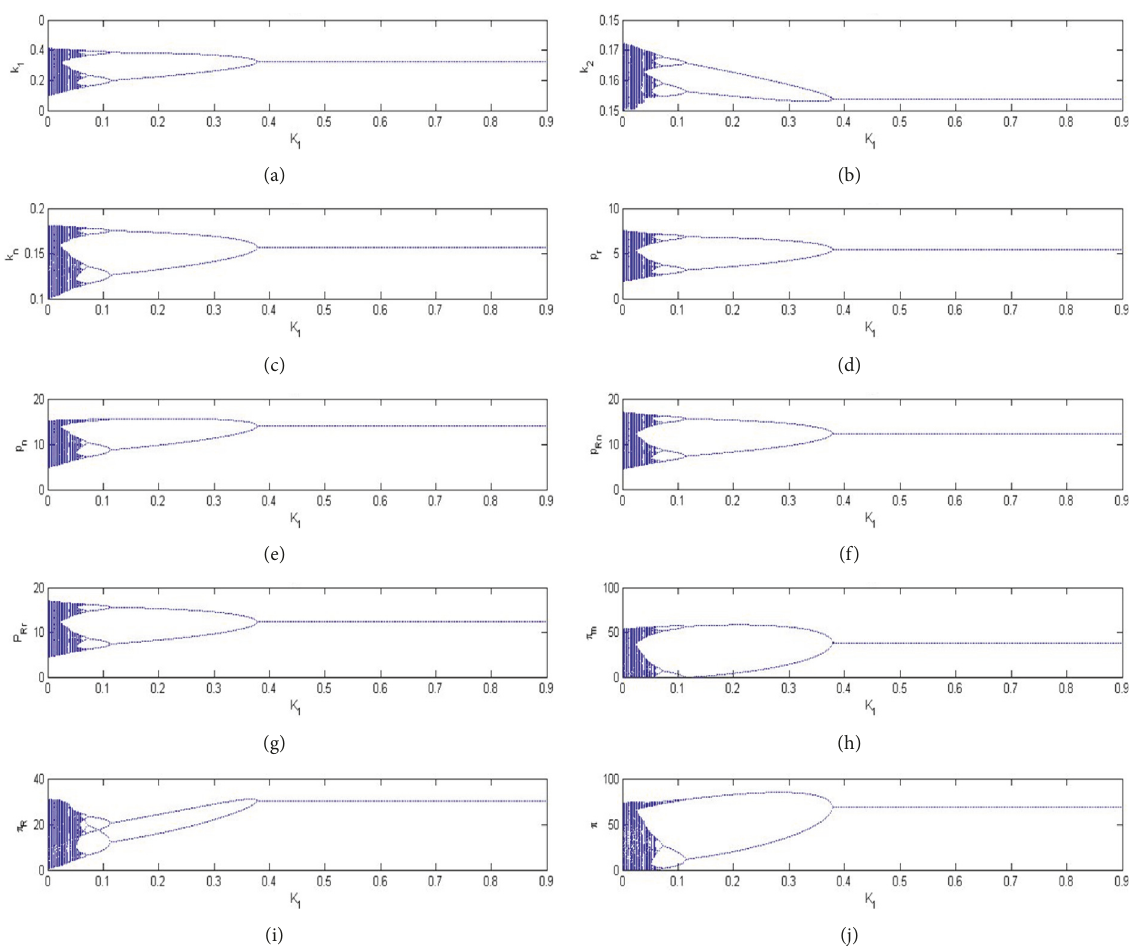
Figure 6: Bifurcation diagrams and the maximum Lyapunov exponent of system (11) with the controlling factor 𝐾 1 .